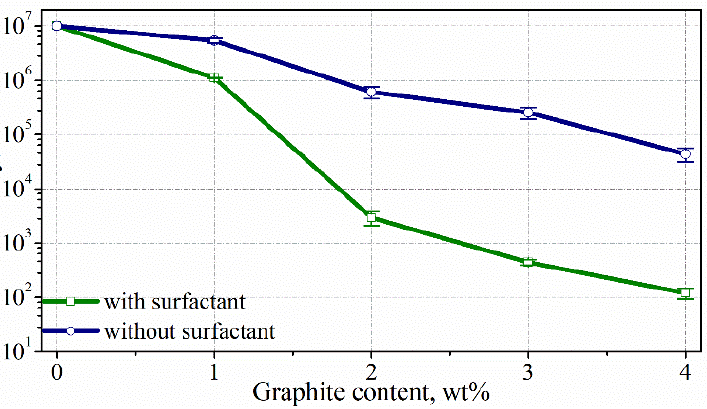
Figure 7. Relationship between resistivity and graphite content for composites with ( green line ) and without ( blue line ) surfactant.